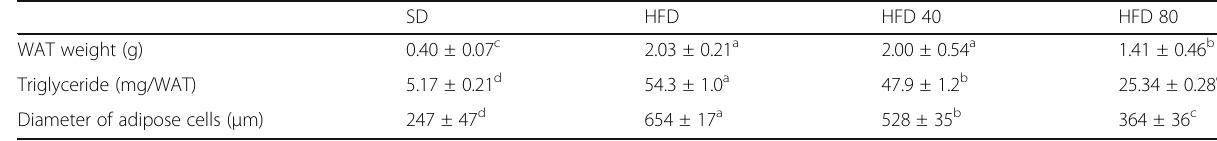
Table 5 Effect of purpurin on white adipose tissue (WAT) weight, morphometry, and triglyceride